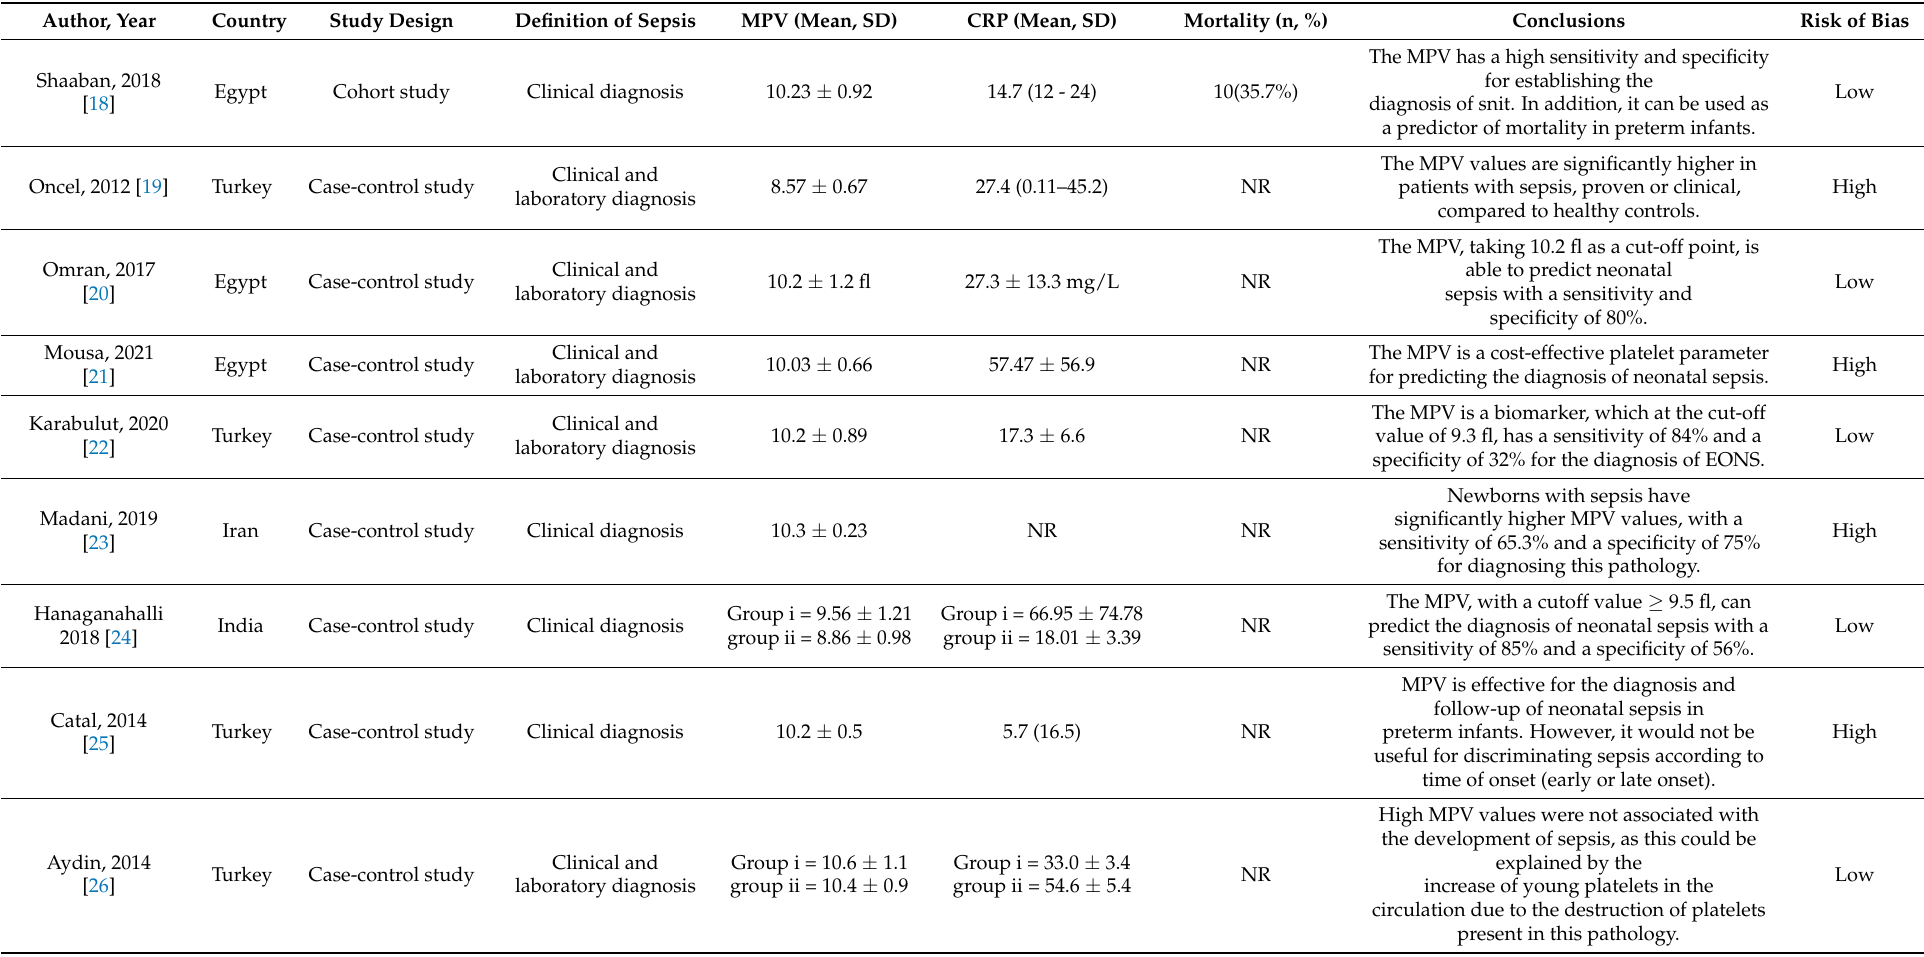
Table 1. Characteristics of Included